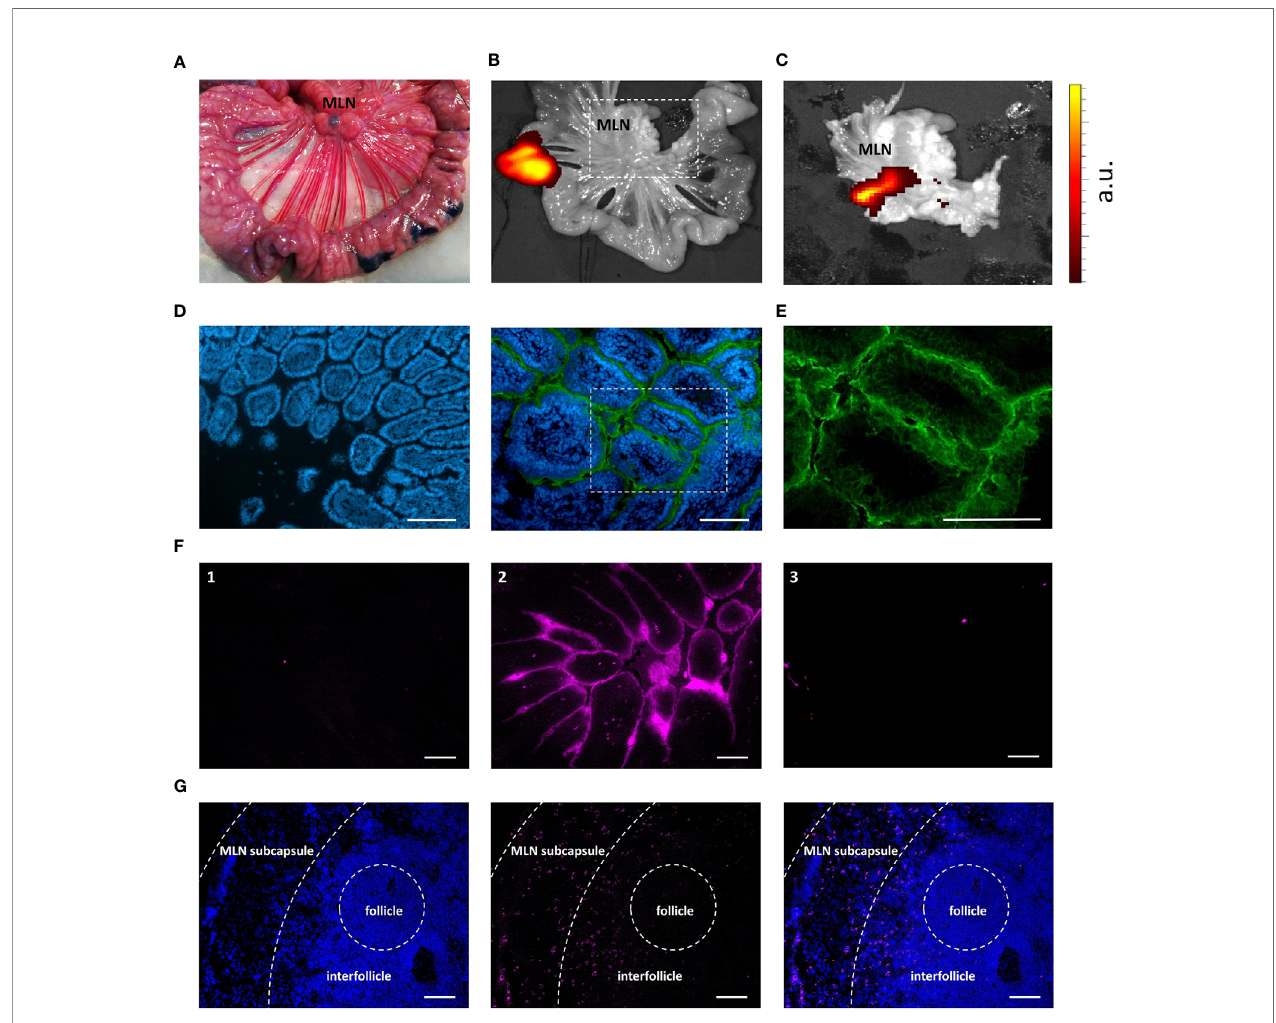
FIGURE 3 | Uptake, endocytosis and migration of IMM013 from the gut mucosa to the mesenteric lymph nodes. (A) Ligated jejunal loop injected subserosally with Evans Blue to localize the draining mesenteric lymph nodes (MLN). Photograph taken 5 minutes after injection. (B) Ligated jejunal loop injected with 1 mg of IMM013-DL755. Image captured 5 hours after injection. (C) Squared box in b. Intensity scale from low (red) to high (yellow). a.u: arbitrary units (D) Immunostaining of a gut ligated loop injected with IgG1 isotype (left) and IMM013 (right); nuclei (blue), FITC-conjugated anti-mouse IgG (Green). Scale bar: 100µm. (E) Squared box in d. (F) Cryosections from ligated gut loops injected with (1) PBS, (2) IMM013-DL755 and (3) IgG1-DL755. Images taken from unprocessed cryosections. Scale bar: l00µm. (G) Immunohistochemistry of a draining MLN; nuclei (left, blue), IMM013-DL755 (center, magenta) and merge (right). Images taken from unprocessed cryosections. Scale bar: 100 µm. Images are representative of three